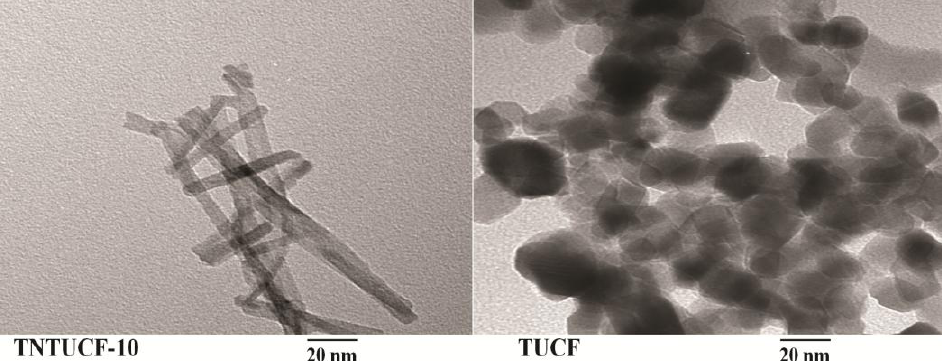
Figure 1. Scanning electron microscopy (SEM) of titania nanotube arrays grown on un-activated carbon fibers (TNTUCFs) with different TiO